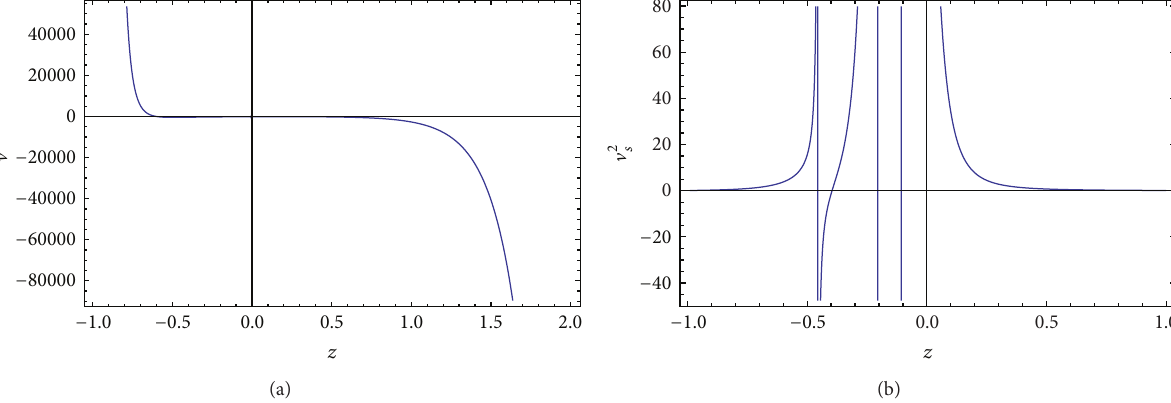
Figure 12: Evolution of squared speed of sound versus 𝑧 for the reconstructed quintessence and holographic 𝑓(𝑇) models. Left plot shows the quintessence 𝑓(𝑇) model with Ω 𝑚0 = 0.315 , 𝐻 0 = 67.3 , and 𝜔 = −1 and right plot shows the evolution of holographic 𝑓(𝑇) model for 𝑐 = 0.6